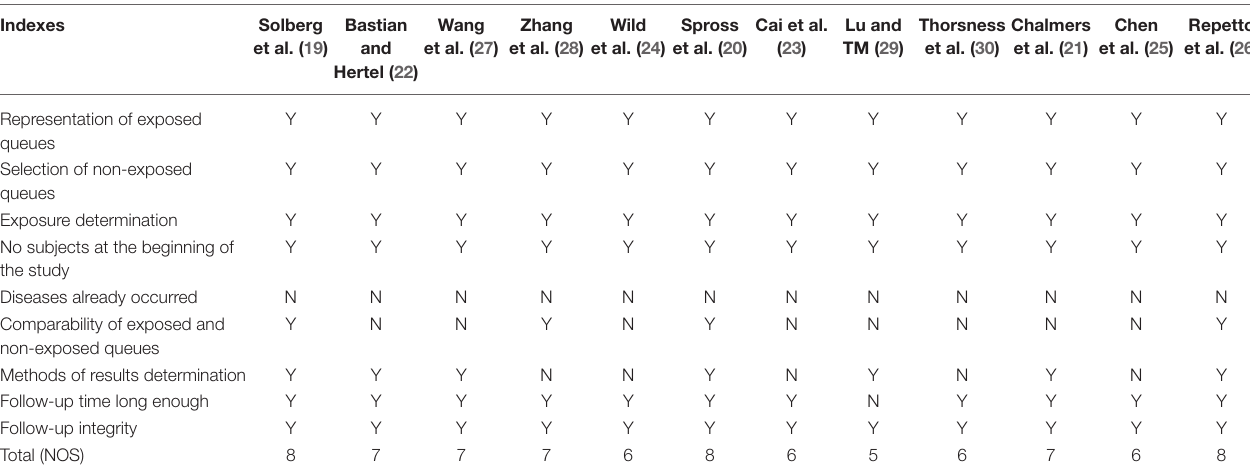
TABLE 2 | Methodological quality assessment of included